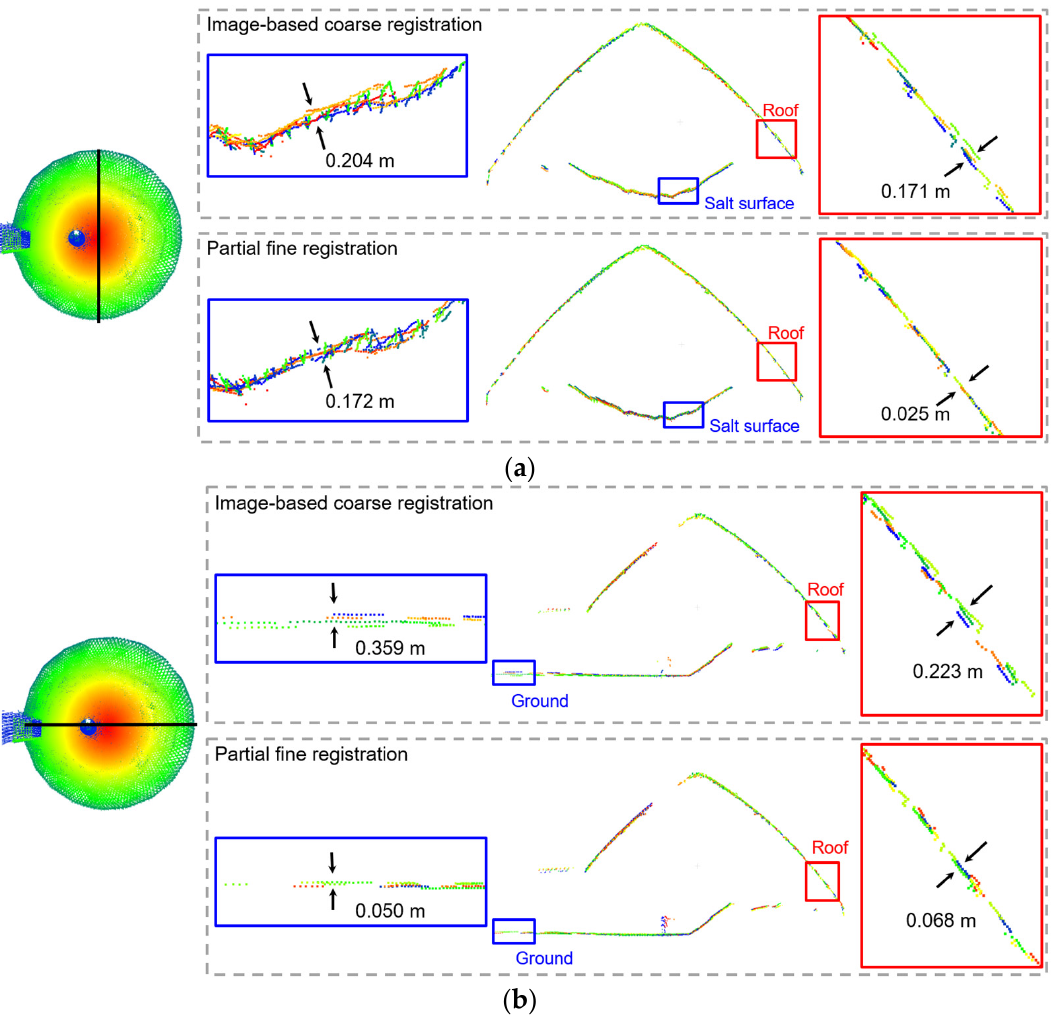
Figure 30. Extracted vertical profiles (width: 0.2 m) from the West Lafayette dataset before/after partial fine registration (the arrows indicate the direction of the measured distance): ( a ) profile orthogonal to the entrance walls and ( b ) profile parallel to the entrance walls.